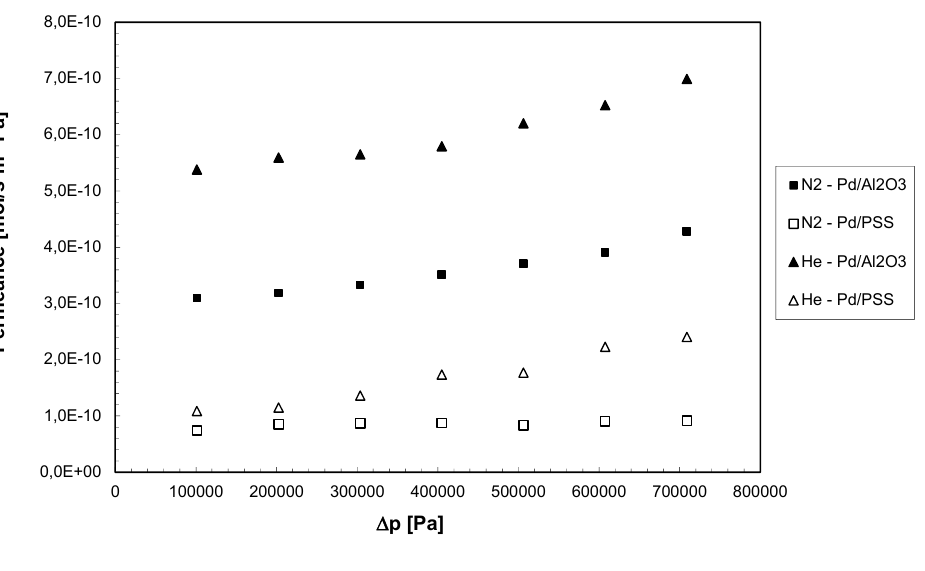
and CO permeances as a function of the trans-membrane pressure difference Table 1. CH 4 2 for both Pd-based composite membranes at T = 400